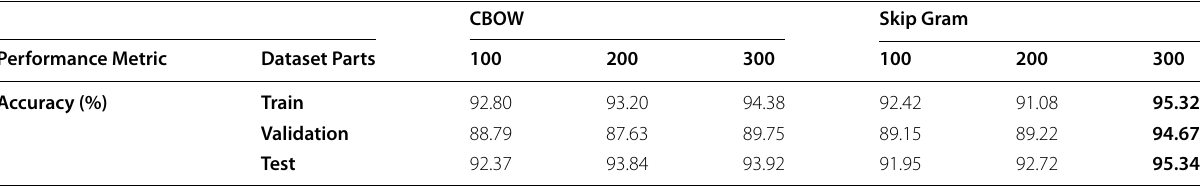
Table 7 Accuracy values of the proposed model (80%-20%)